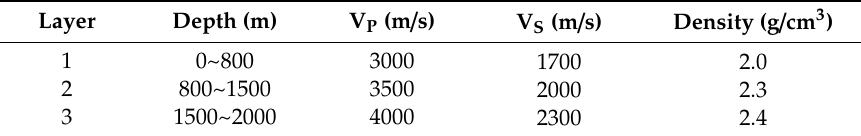
Figure 2. Multi-layered VTI model, source, and observation system. The red star is the source; the blue dots are the detectors distributed on two survey lines (402 geophones in total, with 10 m spacing). Table 1. Media parameters for multi-layered VTI model.